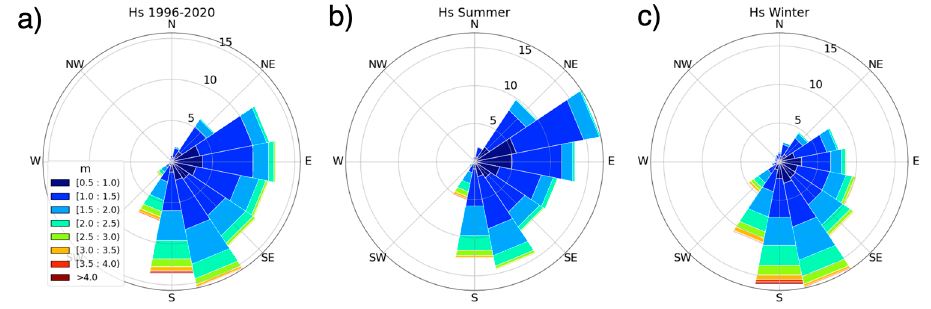
Figure 4. Rose diagrams for Hs and wave directions from global wave reanalysis: ( a ) for the complete period (1996–2020), ( b ) summer, ( c ) winter.